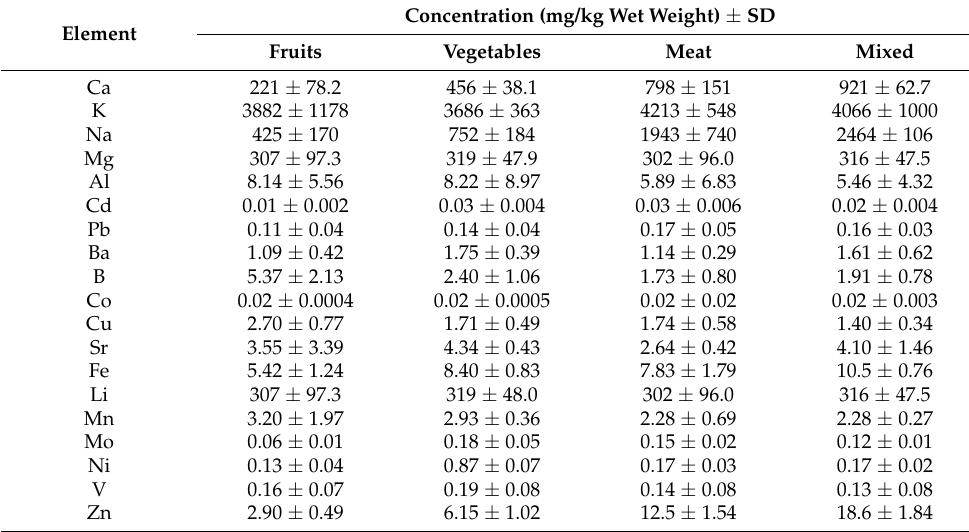
Table 5. Concentration (mg/kg wet weight) and standard deviation (SD) of the analyzed metals in the samples of baby food jar. Concentration (mg/kg Wet Weight) ± SD Element Fruits Vegetables Meat Mixed